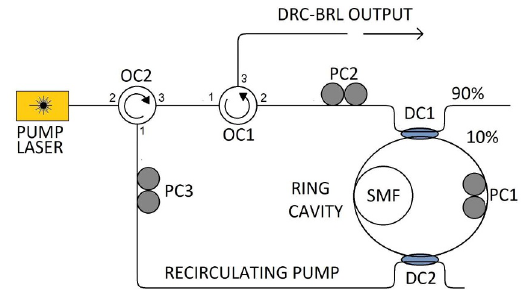
Fig. 1. Scheme of the SC-BRL with self-injection locking .